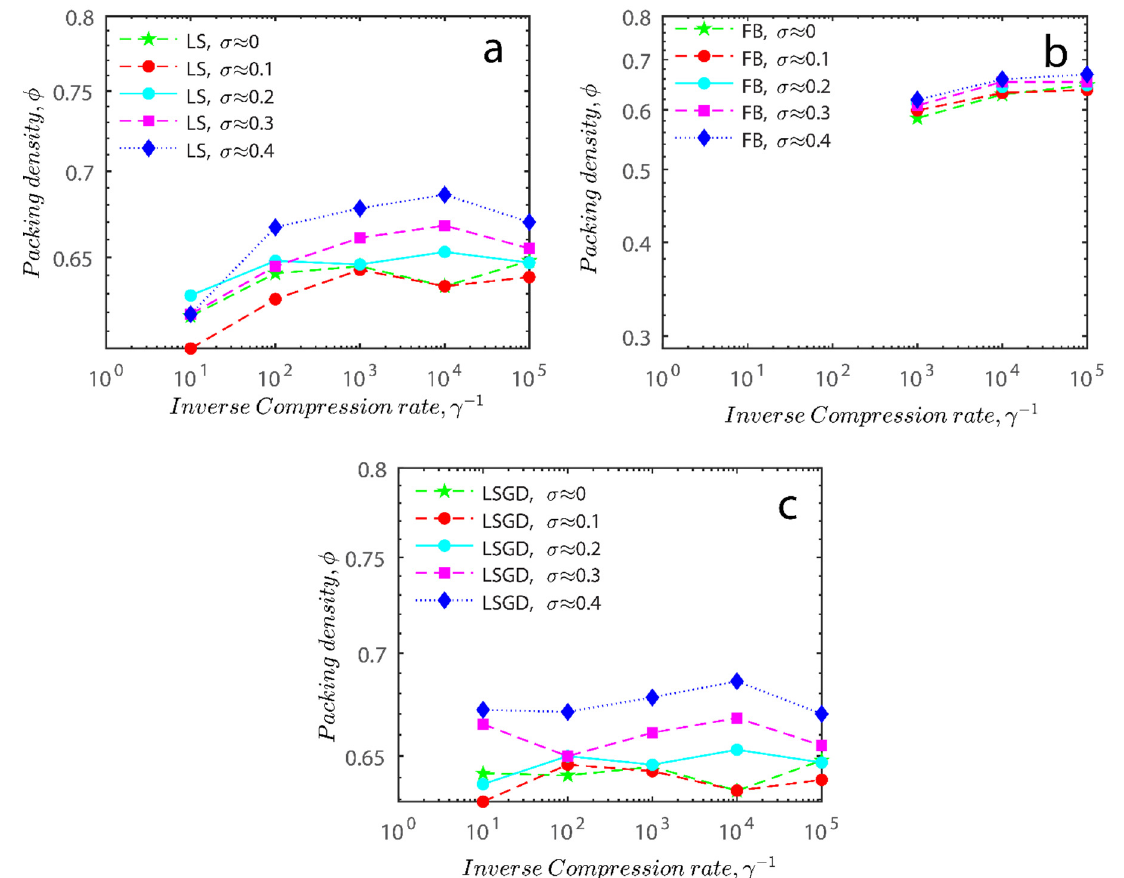
Figure 11. Inverse compression rate vs packing density (volume fraction) estimated as a function of log-normal polydispersity and using three different algorithms. ( a ) The Lubachevsky–Stillinger (LS) algorithm-generated sphere packing densities; ( b ) the force-biased (FB) algorithm-generated densities of spherical packings; ( c ) the LSGD algorithm-generated densities of spherical packings for polydisperse particles.